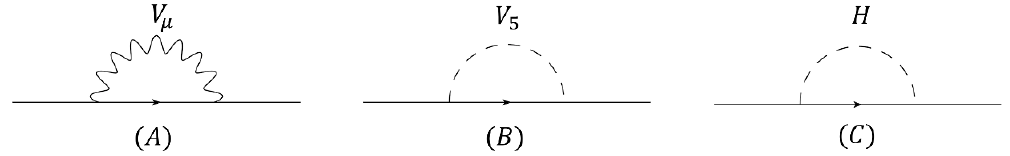
Figure 2 . Generic Feynman diagrams for the one-loop contributions to the self-energies of KK scalars. See caption of (cid:12)gure 1 for further explanations.